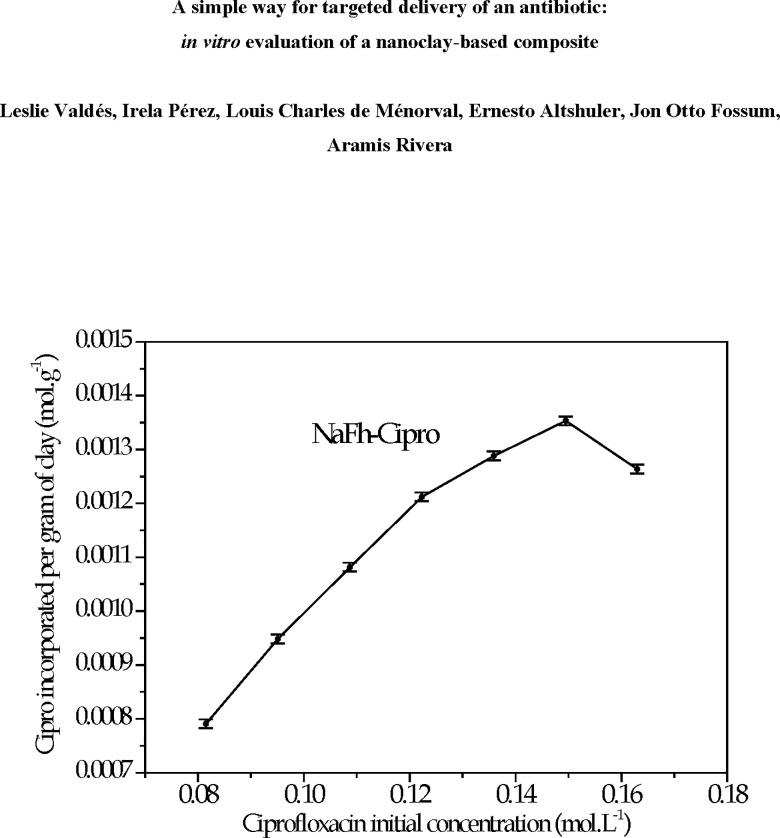
Dependence of the amount of Cipro incorporated into clay with the drug initial concentration.